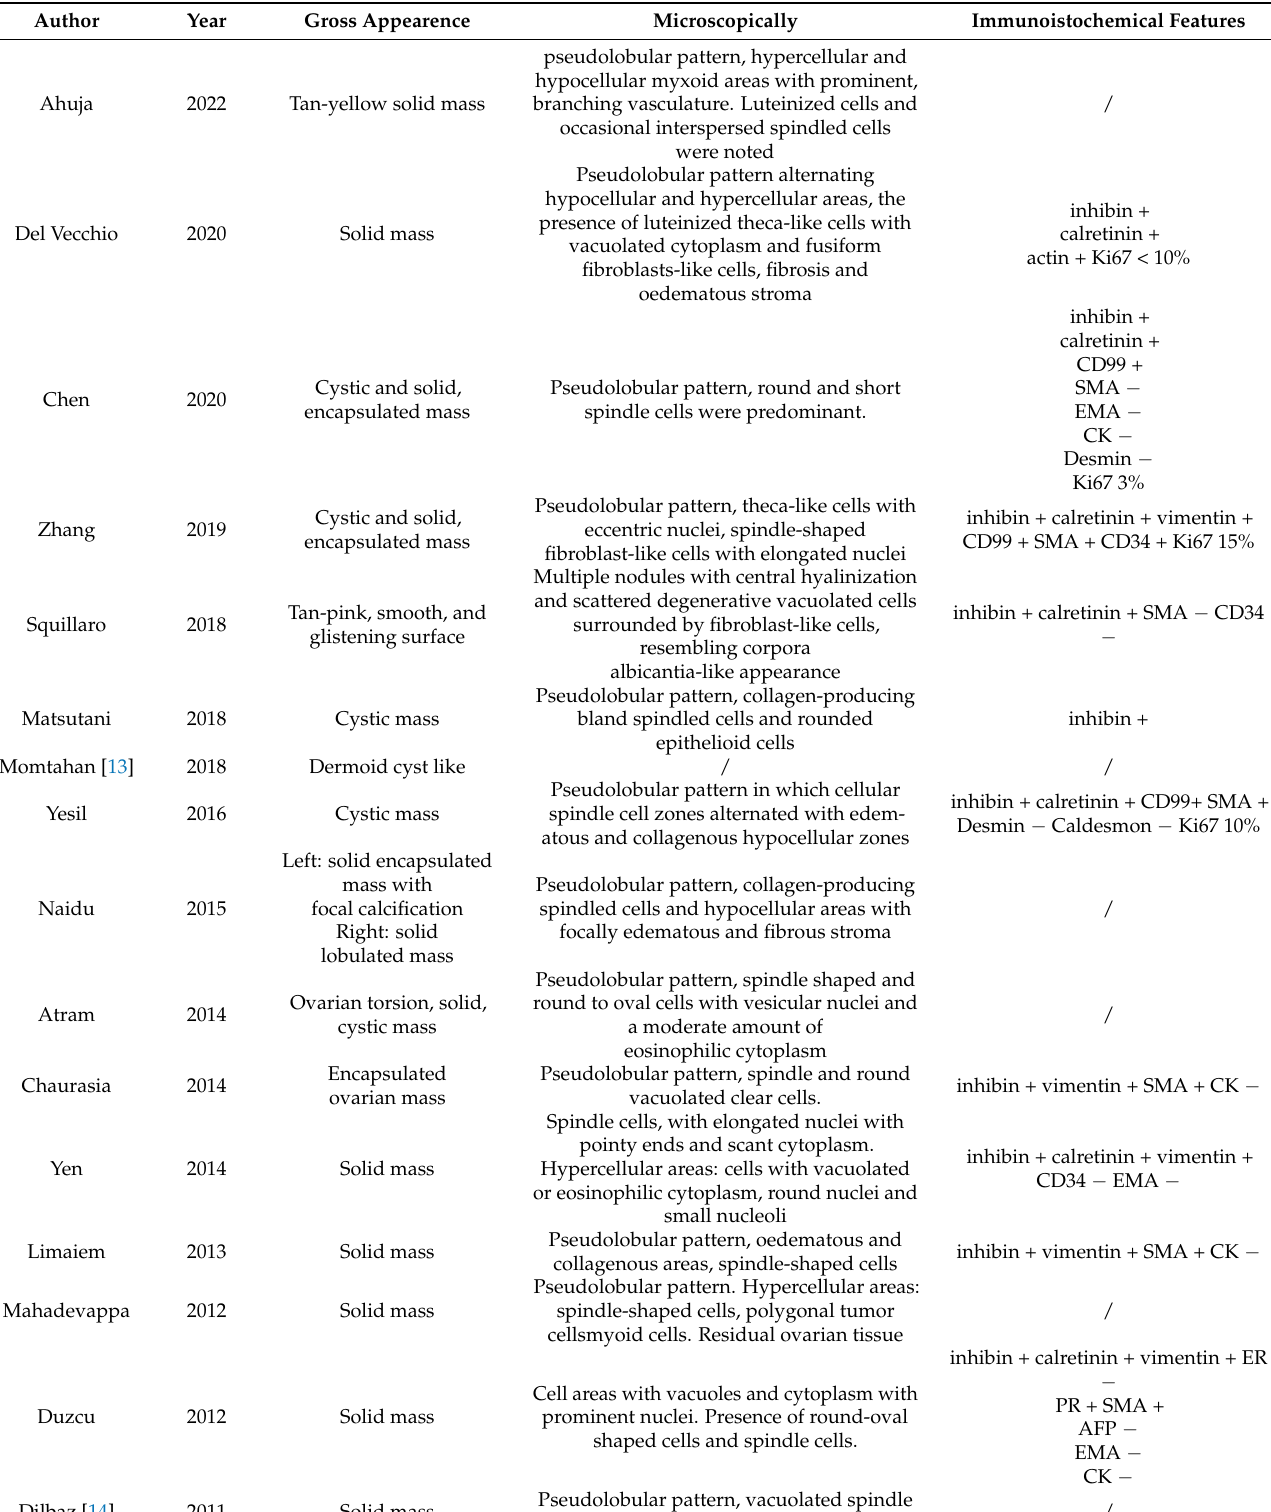
Table 3. List of the clinical cases reviewed in the literature and their characteristics: tumor size, laterality, age of the patient, clinical manifestations at entry, markers, blood test results, macroscopic appearance, type of surgery performed, and microscopic characteristics.